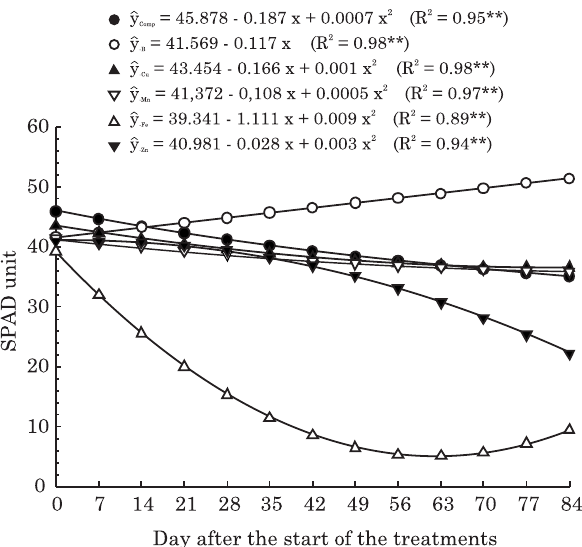
Figure 4. Chlorophyll content, in SPAD units, measured on the middle lobe of the third and fourth recently expanded leaves of physic nut grown in complete nutrient solution and in absence of B, Cu, Fe, Mn, and Zn, according to the evaluation day.